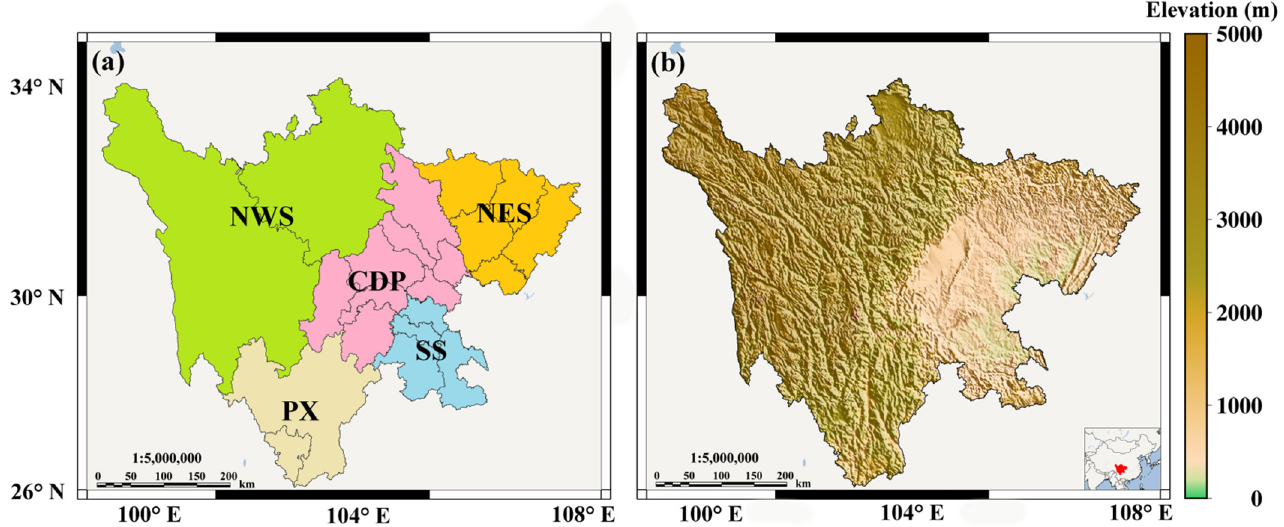
Figure 1. The economic regions ( a ) and digital elevation model ( b ) of Sichuan.